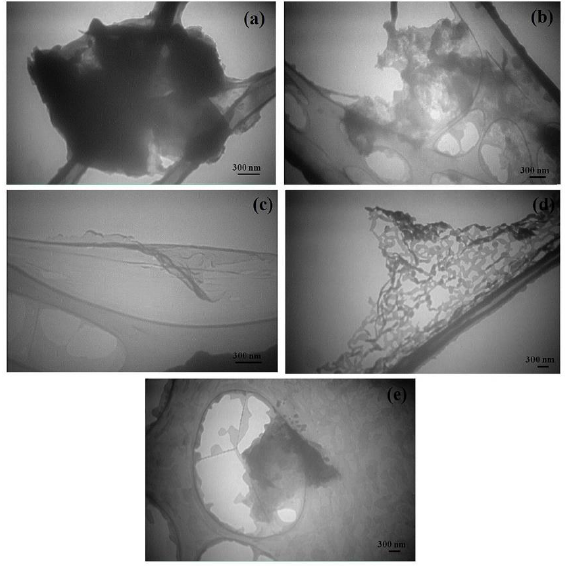
Figure 18. TEM images of GO nanosheets in different concentrations of CTAB: ( a ) 0.02 M, ( b ) 0.04 M, ( c ) 0.06 M, ( d ) 0.08 M, and ( e ) 0.1 M. Reprinted with permission from Ref. [79]. 2018, Elsevier.